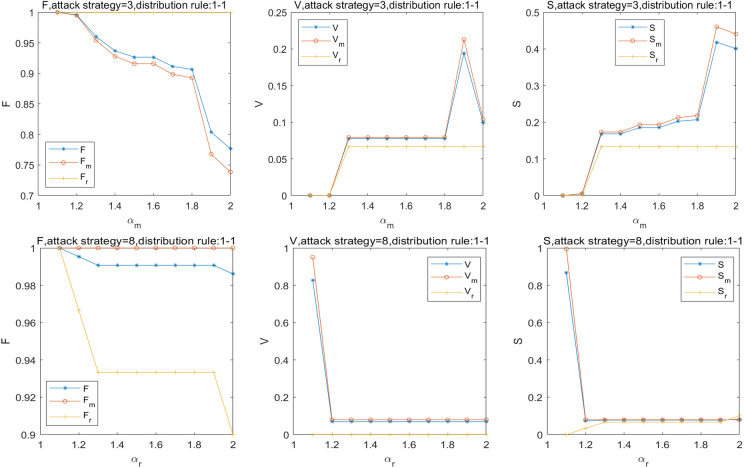
Effect of αm & αr on robustness of the SRN.